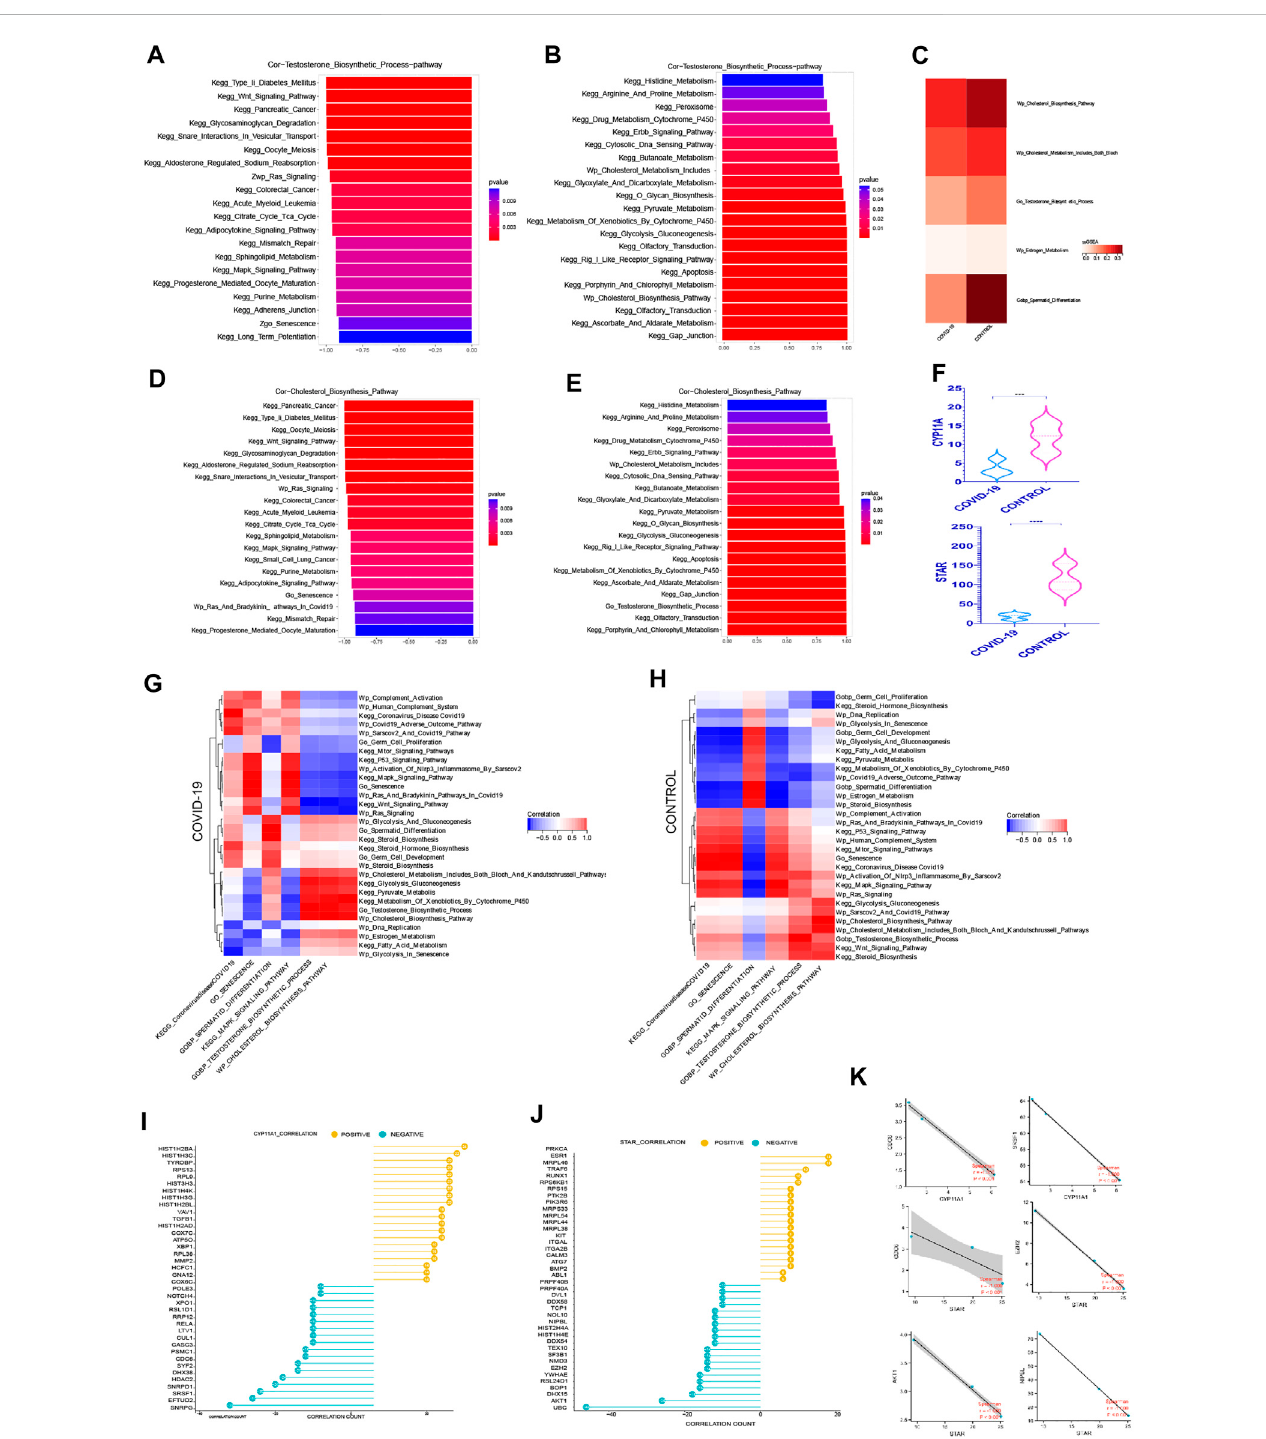
FIGURE 4 The Prominent Negative Role of Cellular senescence on Androgen Synthesis (A) The top 20 pathways in COVID-19 were signi fi cantly negatively correlated with testosterone synthesis pathway, among which Go Senescence pathway was the most relevant ( r = − .91, p < .001). (B) The top 20 pathways in COVID-19 were signi fi cantly positively correlated with testosterone synthesis pathway, among which Cholesterol Biosynthesis Pathway play an importance role in those. (C) ssGSEA score of Wp Cholesterol Biosynthesis Pathway, Wp Cholesterol Metabolism,testosterone synthesis pathway decreased in COVID-19. (D) The top 20 pathways in COVID-19 were signi fi cantly negatively correlated with cholesterol synthesis pathway, among which Go Senescence pathway was the most relevant ( r = − .93, p < .001). (E) The top 20 pathways in COVID-19 were signi fi cantly positively correlated with cholesterol synthesis pathway. (F) Thesetworate-limitingenzymesfor cholesterol synthesis decreasedinCOVID-19infection(STAR, CYP11A1). (G) Thecorrelationoftestosterone synthesis pathway, cholesterol biosynthesis Pathway with GO gene sets, KEGG pathways, and WIKIPATHWAYS pathways in COVID-19 group. (H) The correlation of testosterone synthesis pathway, cholesterol biosynthesis Pathway with GO gene sets, KEGG pathways, and WIKIPATHWAYS pathways in the Controlgroup. (I) Thetop20genesstrongnegativecorrelationwithSTAR( r < − .9, p < .05)byPPIandthetop20genesstrongpositivecorrelationwithSTAR( r > .9, p < .05) by PPI. (J) The top 20 genes strong negative correlation with CYP11A1 ( r < − .9, p < .05) by PPI and the top 20 genes strong positive correlation with CYP11A1 ( r > .9, p < .05) by PPI. (K) Several genes implicated in cell senescence are among the top 20 genes negatively correlated with STAR or